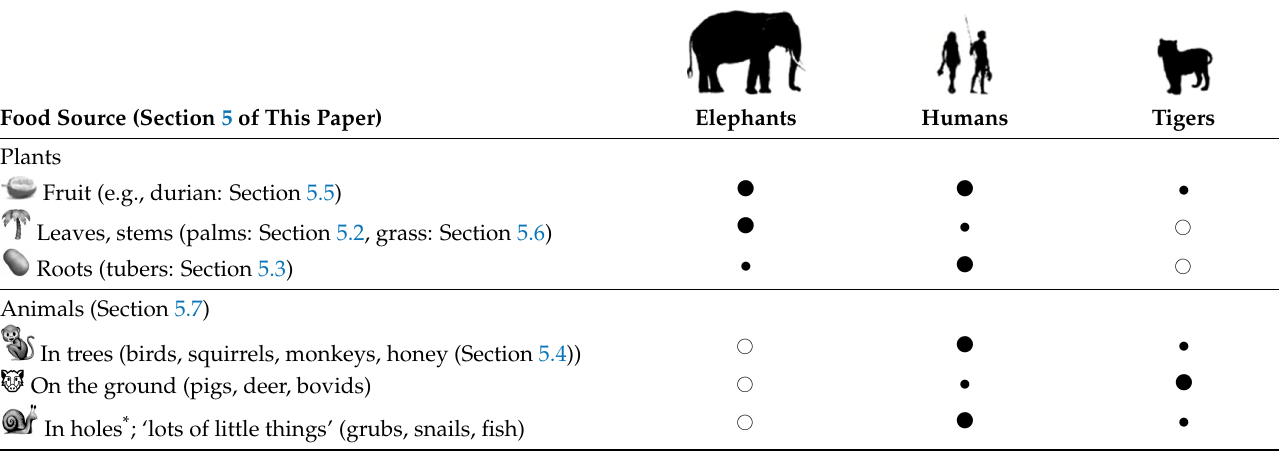
Table 2. Trophic strategies of apex megafauna in Malaysia during the Late Quaternary. Notes: *“Animals in holdes” includes porcupines, pangolins, hornbills, etc. Sources: various, including [36,48,49]. This table outlines the subsections of Section 5 of this paper (the numbers of which are noted in brackets).